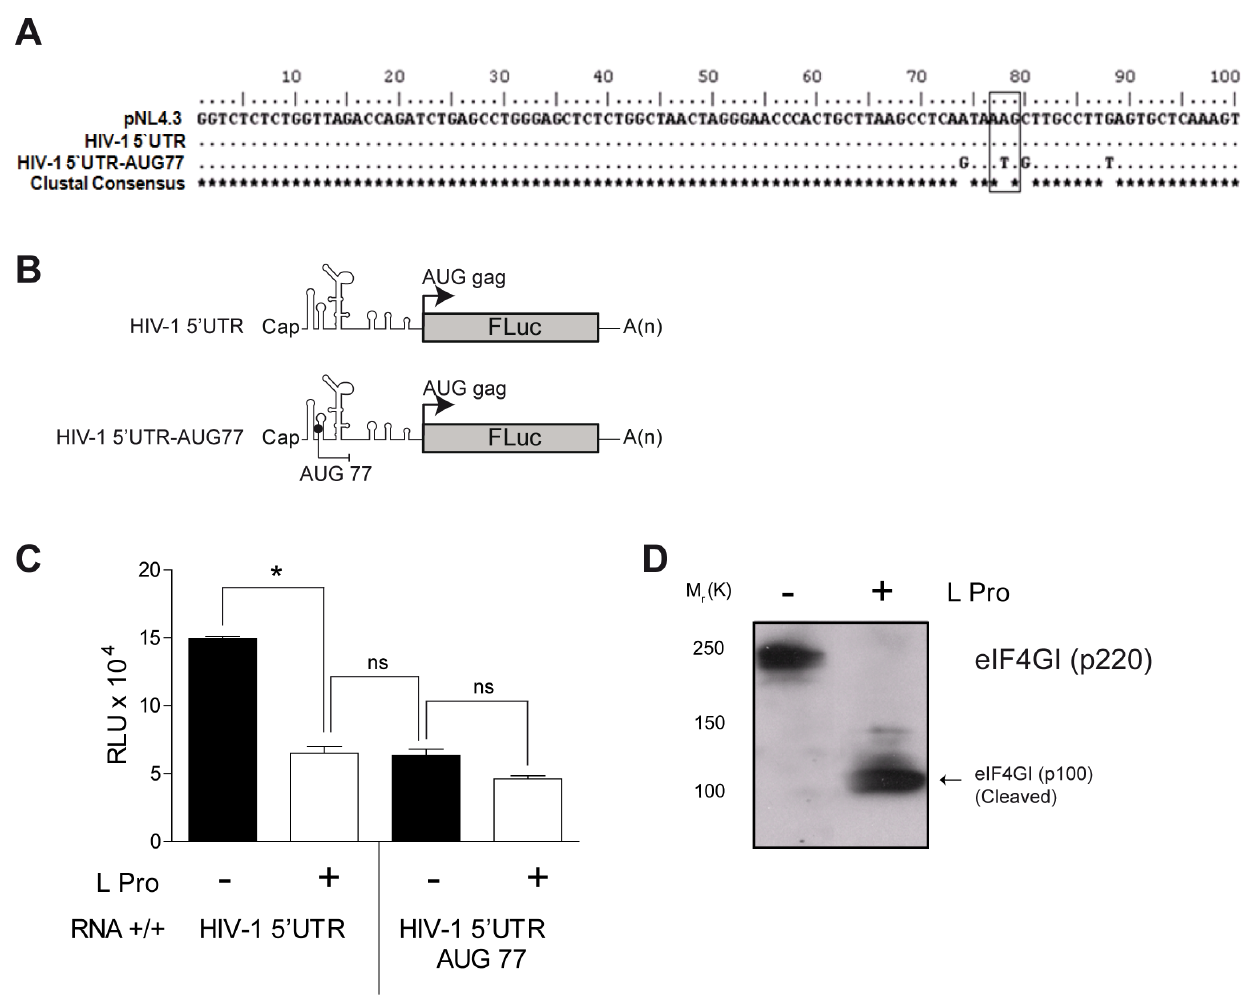
Figure 1. Contribution of the HIV-1 IRES to the overall translational activity displayed by the capped HIV-1 5 9 UTR. (A) The partial sequence of the HIV-1 5 9 UTR from the proviral clone pNL4.3 (AF324493l) was aligned against the intercistronic region, HIV-1 5 9 UTR, recovered from the dl HIV-1 IRES plasmid [16] and the mutant HIV-1 5 9 UTR-AUG 77 in which an optimal initiation codon was inserted at position 77 with respect to the reference sequence. The block highlights the introduced initiation codon. (B) Schematic representation of the capped and polyadenylated monocistronic mRNAs used in this study. In the HIV-1 5 9 UTR monocistronic RNA the 5 9 UTR of the full-length HIV-1 mRNA was cloned upstream of the FLuc reporter. The reporter open reading frame (ORF) was left in frame with the Gag protein initiation codon (arrow). In the HIV-1 5 9 UTR AUG 77 monocistronic RNA and additional optimal initiation codon has been added at position 77 upstream of the putative internal ribosome entry site (IRES) and out of frame (end point line) with respect to the FLuc ORF. (C) In vitro transcribed capped and polyadenylated ( + / + ) RNA were translated in absence ( 2 ; black bar) or presence ( + ; white bar) of FMDV L protease [33]. Values are the means 6 SEM from three independent experiments each conducted in triplicate. (D) Analysis of eIF4GI cleavage. RRL translation reactions (10 ul) without (lane 1) or with (lane 2) FMDV L protease (2% V/V) were resolved by SDS/gradient 5%–20% PAGE, transferred to nitrocellulose membrane, detected using polyclonal antibodies eIF4GI as previously described [33]. Statistical analysis was performed by Student t -test (*p , 0.05).